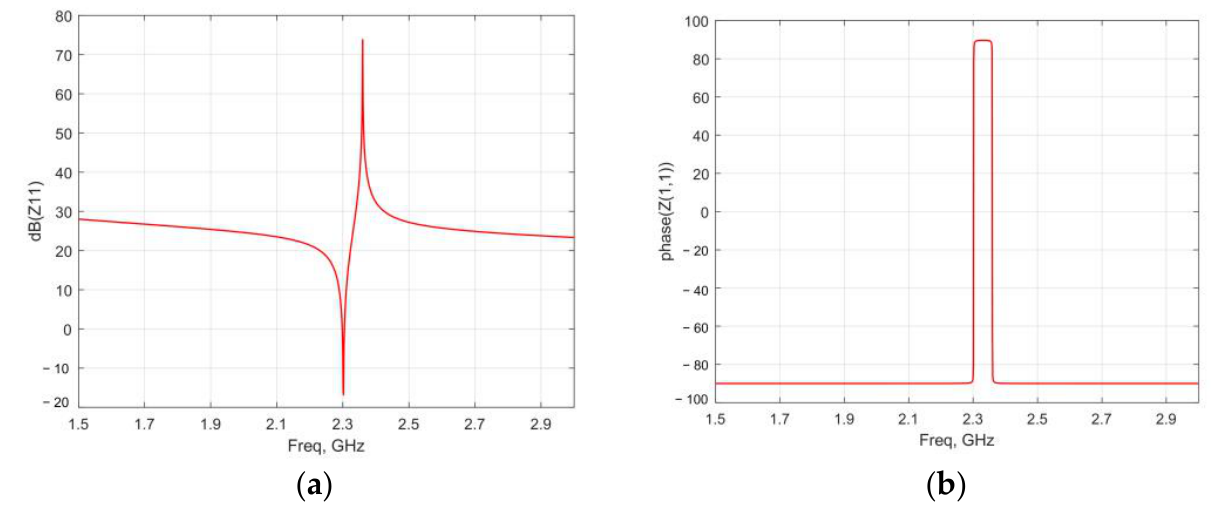
Figure 4. Amplitude ( a ) and phase ( b ) of the antenna impedance.